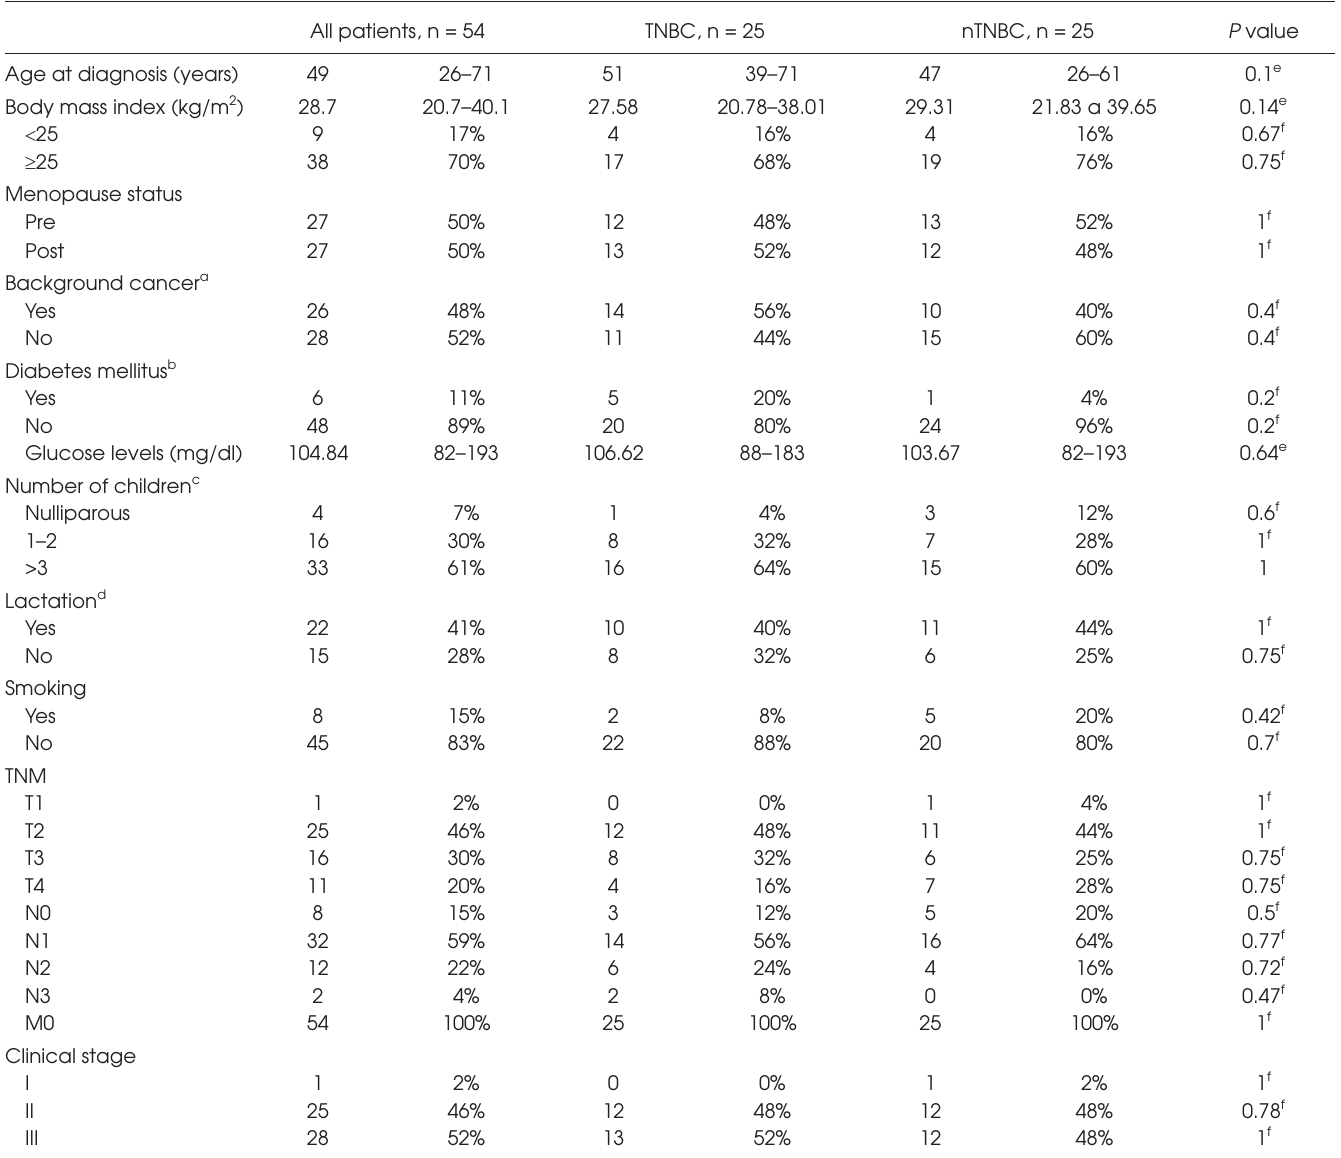
table 1. Patient and tumor characteristics. All patients, n = 54 TNBC, n =